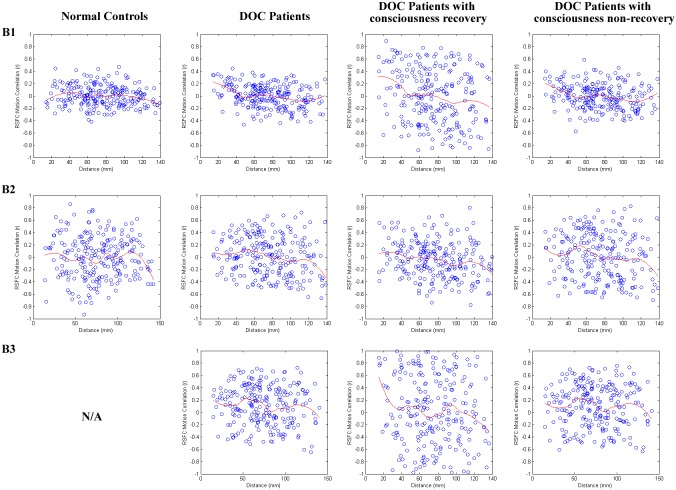
Correlations between motion artifact and neuroanatomical distance between the ROIs in this study.Prior studies have shown that motion artifacts tend to vary with neuroanatomical distance between brain nodes. Here, we conducted quality control analyses as described in the previous study (Power et al., 2015). Specifically, we computed correlations between head motion (mean FD) and each resting state functional connectivity (RSFC) feature and plotted them as a function of neuroanatomical distance (mm) for subjects in the training dataset ‘Beijing 750’ (B1), the testing dataset ‘Beijing HDxt’ (B2), and the testing dataset ‘Guangzhou HDxt’ (B3). Smoothing curves (in red) were plotted using a moving average filter.